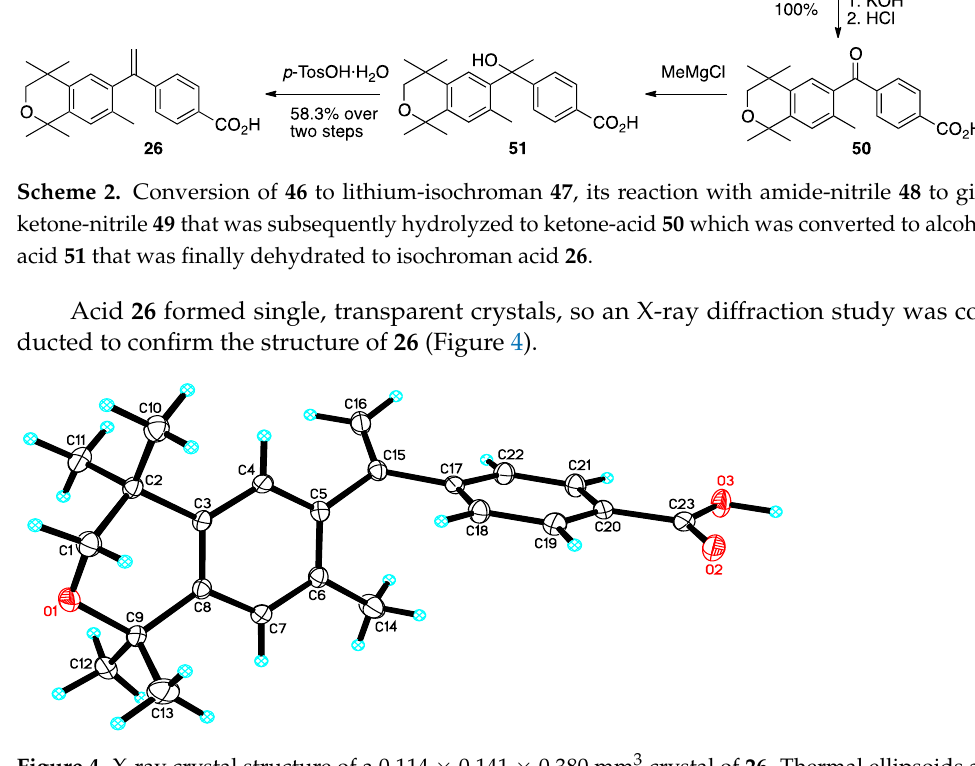
Figure 4. X-ray crystal structure of a 0.114 × 0.141 × 0.380 mm 3 crystal of 26 . Thermal ellipsoids are shown at 50% probability level.